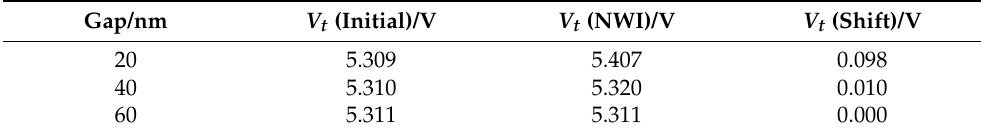
Table 1. V t variation and NWI with three different WL